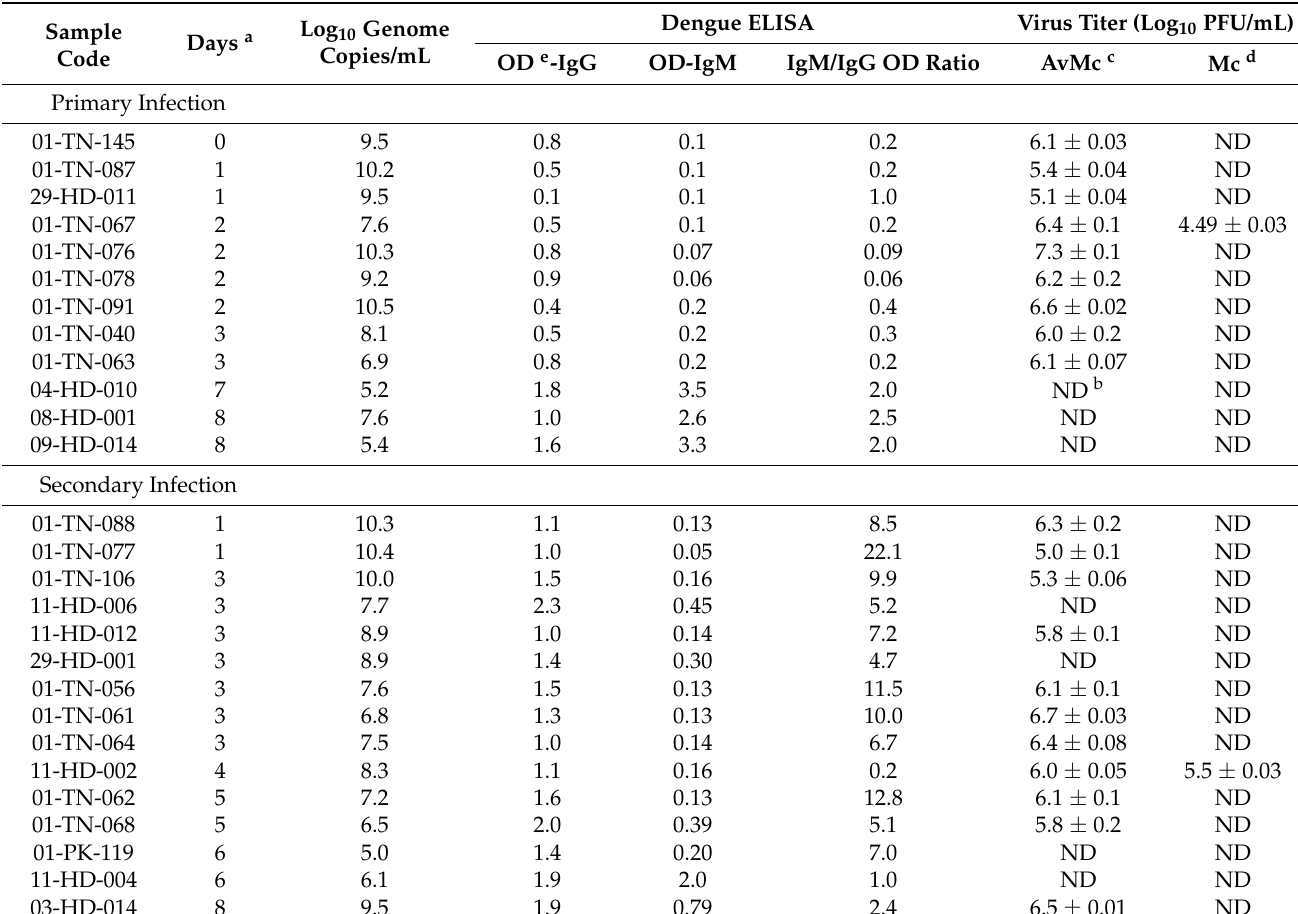
Table 4. Virus titers in primary and secondary DENV-1 infection as determined by plaque assay using Avicel and methylcellulose as the overlay medium.